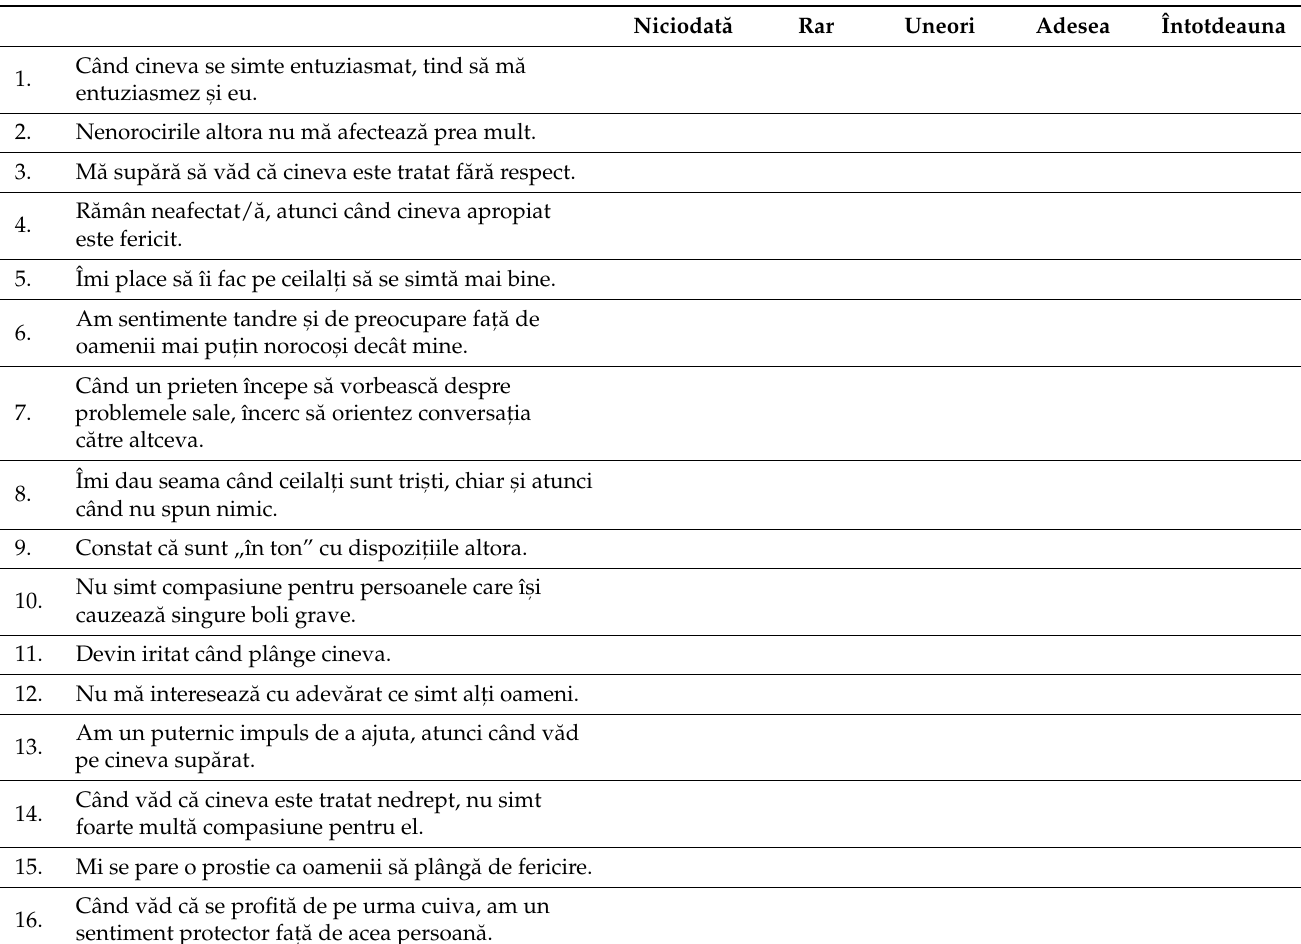
Table A1. Romanian Version of Toronto Empathy Questionnaire